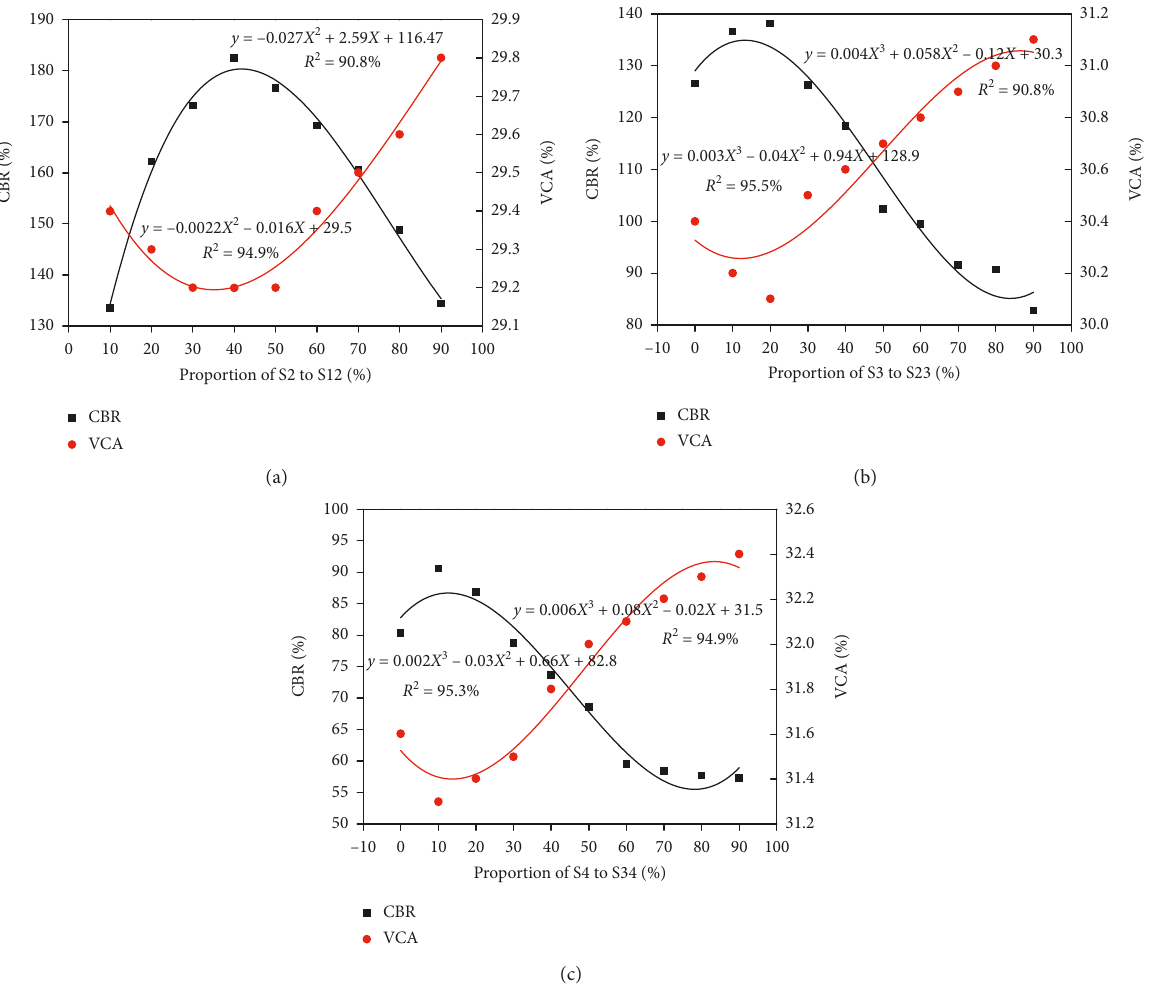
Figure 6: CBR and VCA of three kinds of two-aggregate mixtures with continuous gradation (a) S12, (b) S23, and (c) S34.